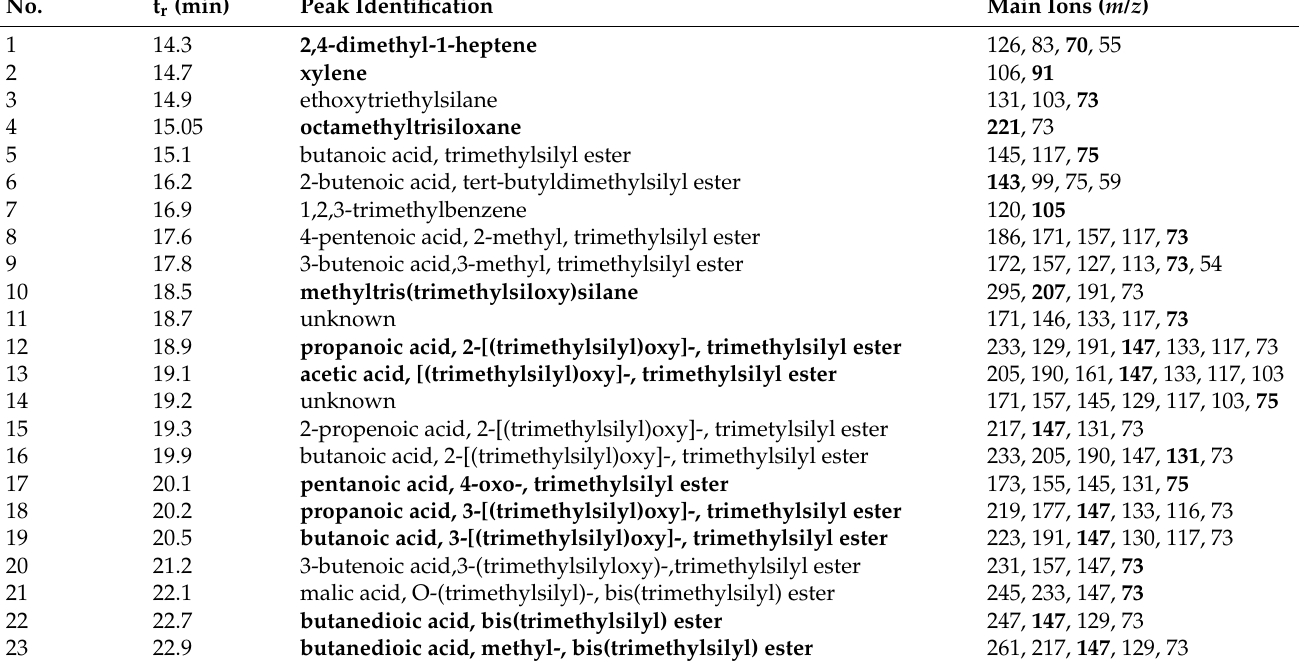
Figure 9. Chromatogram obtained in the Py(HMDS, hexamethyldisilazane)–GC–MS analysis of the dichloromethane (DCM) extract of PP-4w. Peak identification is reported in Table 2. Table 2. Identification of peaks in the chromatogram obtained in the Py(HMDS)–GC–MS analysis of the DCM extract of PP-4w (Figure 9). Bold: most abundant species in the chromatogram; most abundant ions in the mass sppectra.